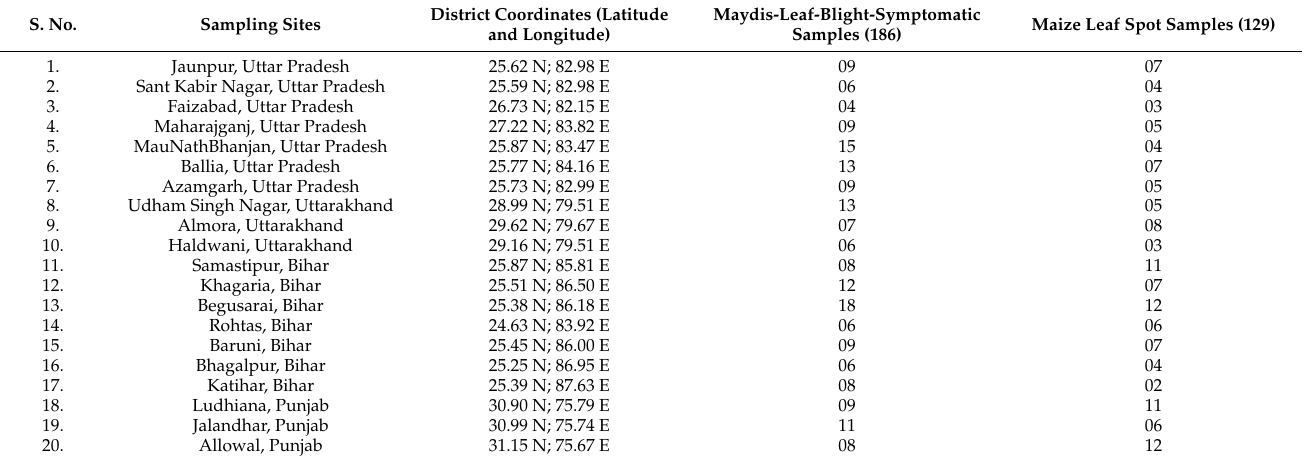
Table 1. Sampling sites of maydis leaf blight and maize leaf spot samples from major maize-growing regions of